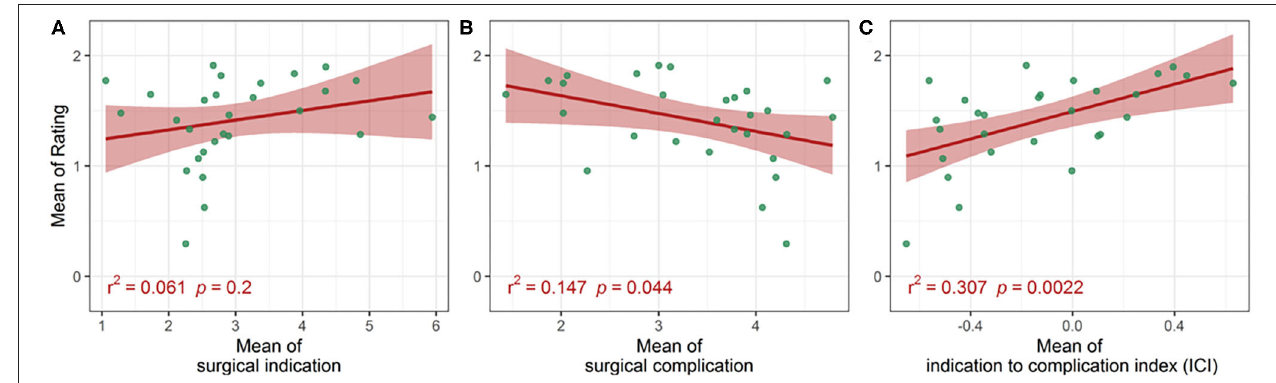
FIGURE 1 | Correlation between the mean (aggregated over each case) of the subjective rating and the mean of the surgical indication (A) ; the mean of the surgical complication (B) ; and the mean of the Indication to Complication Index (ICI; C ).